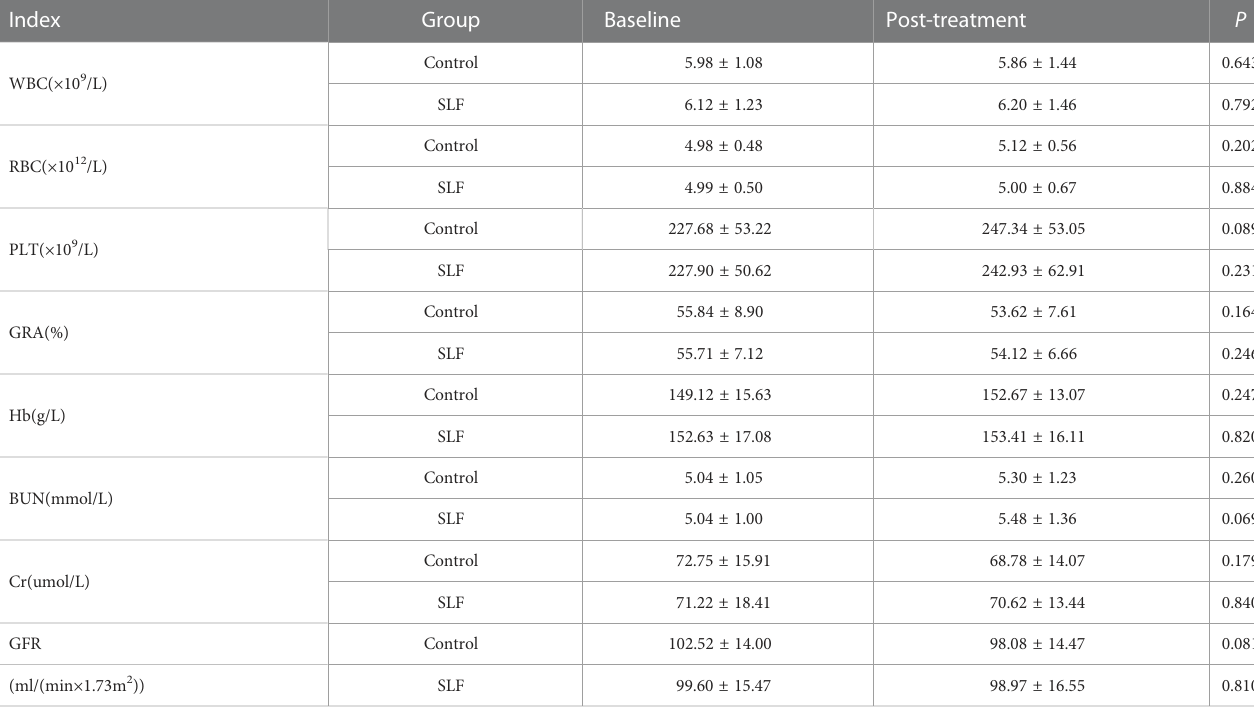
TABLE 2 Comparison of safety indicators between the control group and SLF